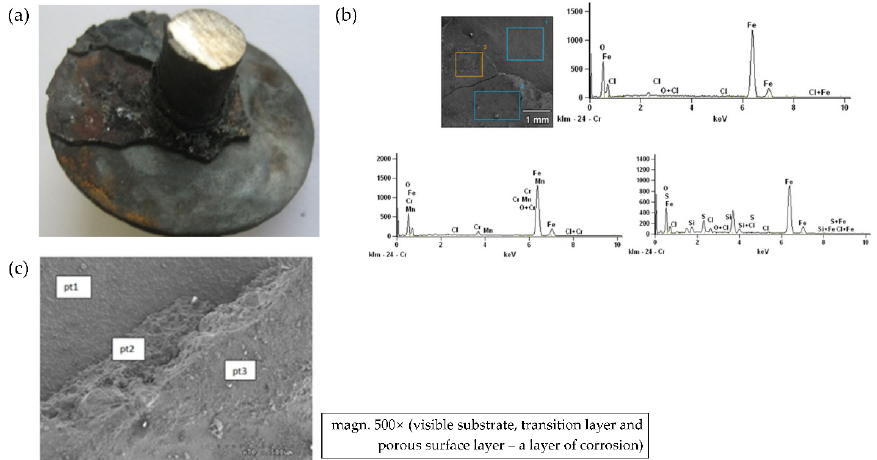
Figure 7. Chlorine corrosion experimental study by Kr ó l et al. [24]. ( a ) A layer of porous corrosion products; ( b ) the numbers 1–3 as marked points represent the chemical composition of the surface of the St41K boiler steel in the planes pt1, pt2, and pt3 on the microscopic photo; ( c ) microscopic photo (SEM) of the surface of the St41K boiler